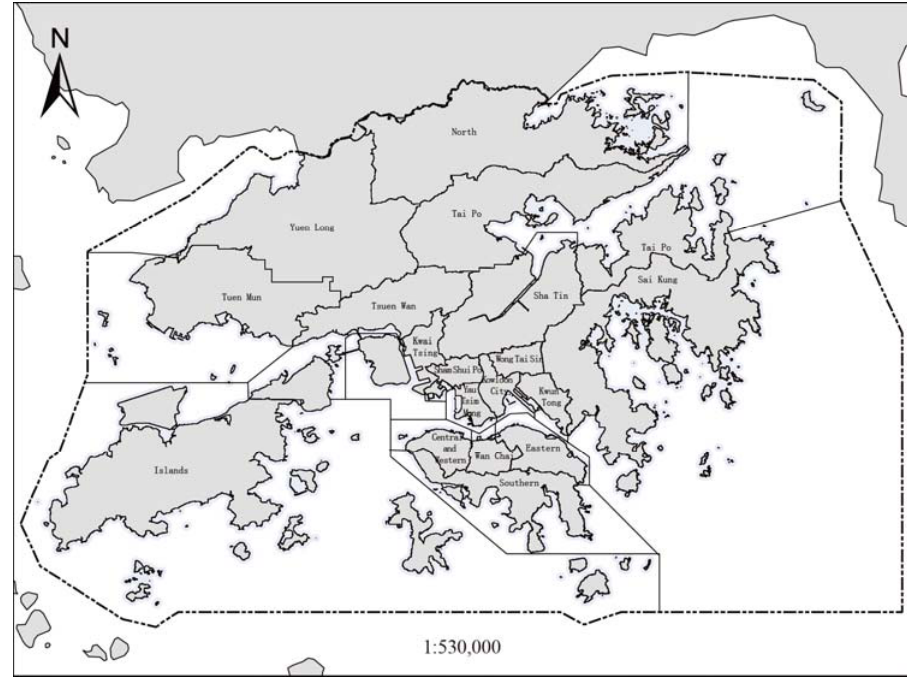
Figure 3. The case study city: Hong Kong.